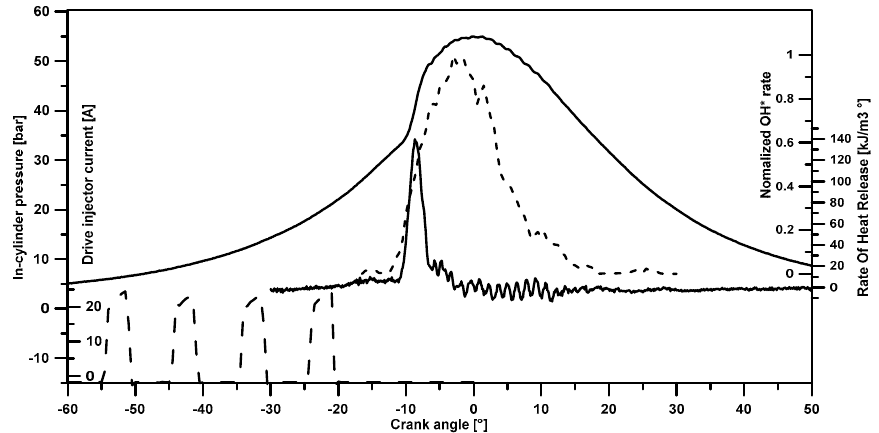
Figure 8. Experimental OH rate evolution when the injection pressure is equal to 700 bar and engine speed fi xed at 1500 rpm, (intake pressure fi xed at 1.7 bar).